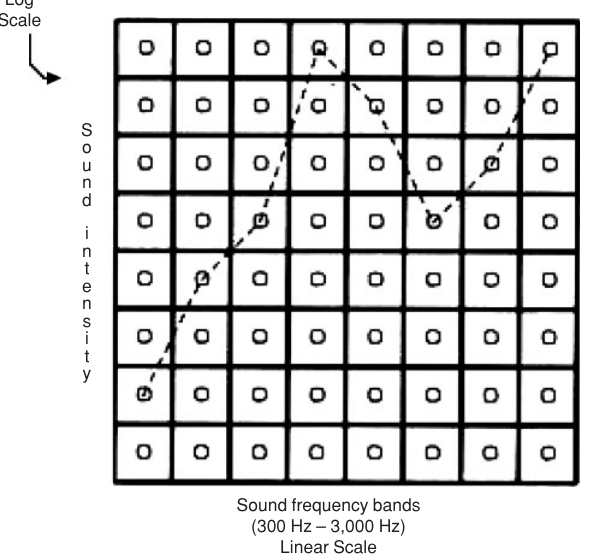
Figure 5 Tactile sound spectrum display matrix.